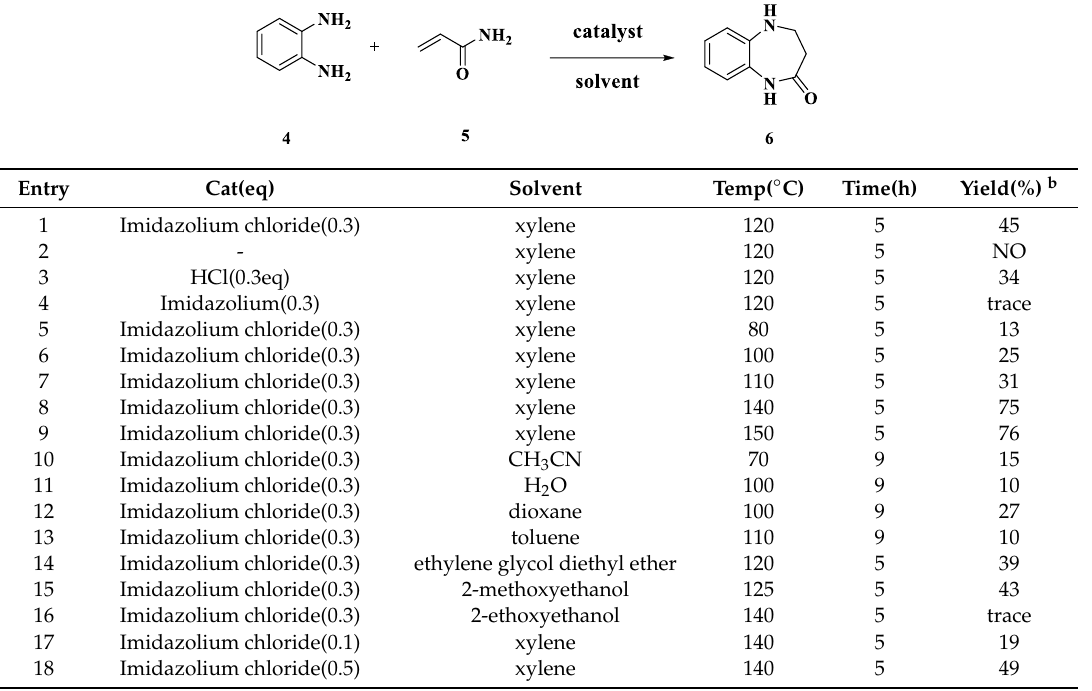
Table 4. Substrate scope of substituted amines and acrylamide derivatives.